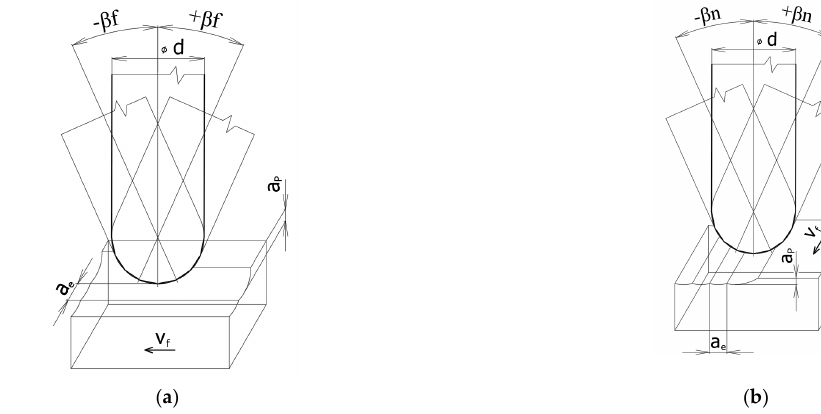
( b ) Figure 3. Tool axis inclination angle β f in feed direction [2,14] ( a ) pulled tool ( b ) pushed tool (d—tool diameter, d eff —effective tool diameter, a p —axial depth of cut). ( a ) ( b ) Figure 4. Tool axis inclination angle in both directions ( a ) Tool axis inclination angle in pick feed direction β n ( b ) Tool axis inclination angle in feed direction β f . The literature [14,22,25] shows how changing the tilting of the tool affects the effec- tive cutter diameter and then the effective cutting speed. The scientific literature describes using the tool axis inclination angle at the range from 10 to 30°. Another scientific paper uses both inclination angles at 15°. References [8,9] recommend a range from 10 to 20°.